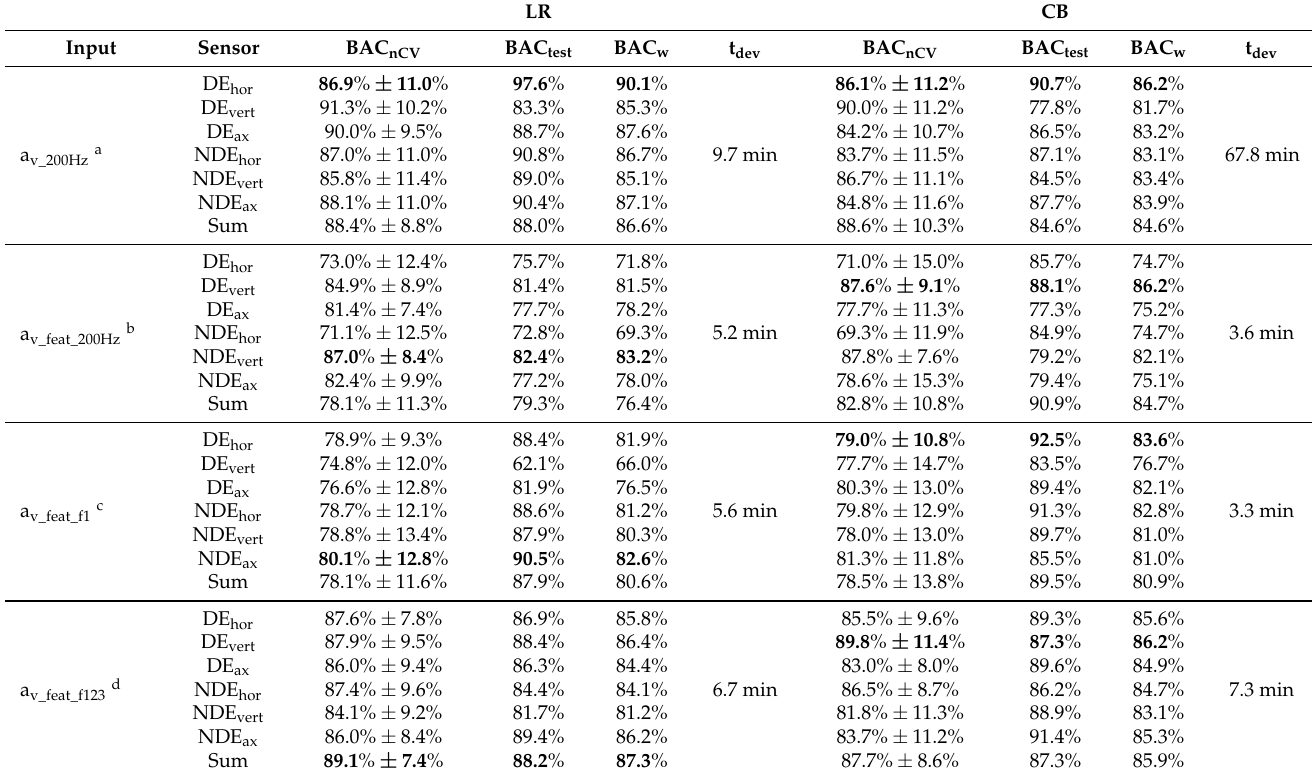
Table 6. Comparison of BAC in nested CV BAC nCV , holdout test dataset BAC test , and weighted BAC w , as well as the computation time required to develop the classifiers when training with different measurement-based datasets. The models were trained using the FFTs of the six vibration acceleration a_v signals and statistical features of these FFTs. For each input type, the results of the sensor data which resulted in the highest BAC w are shown in